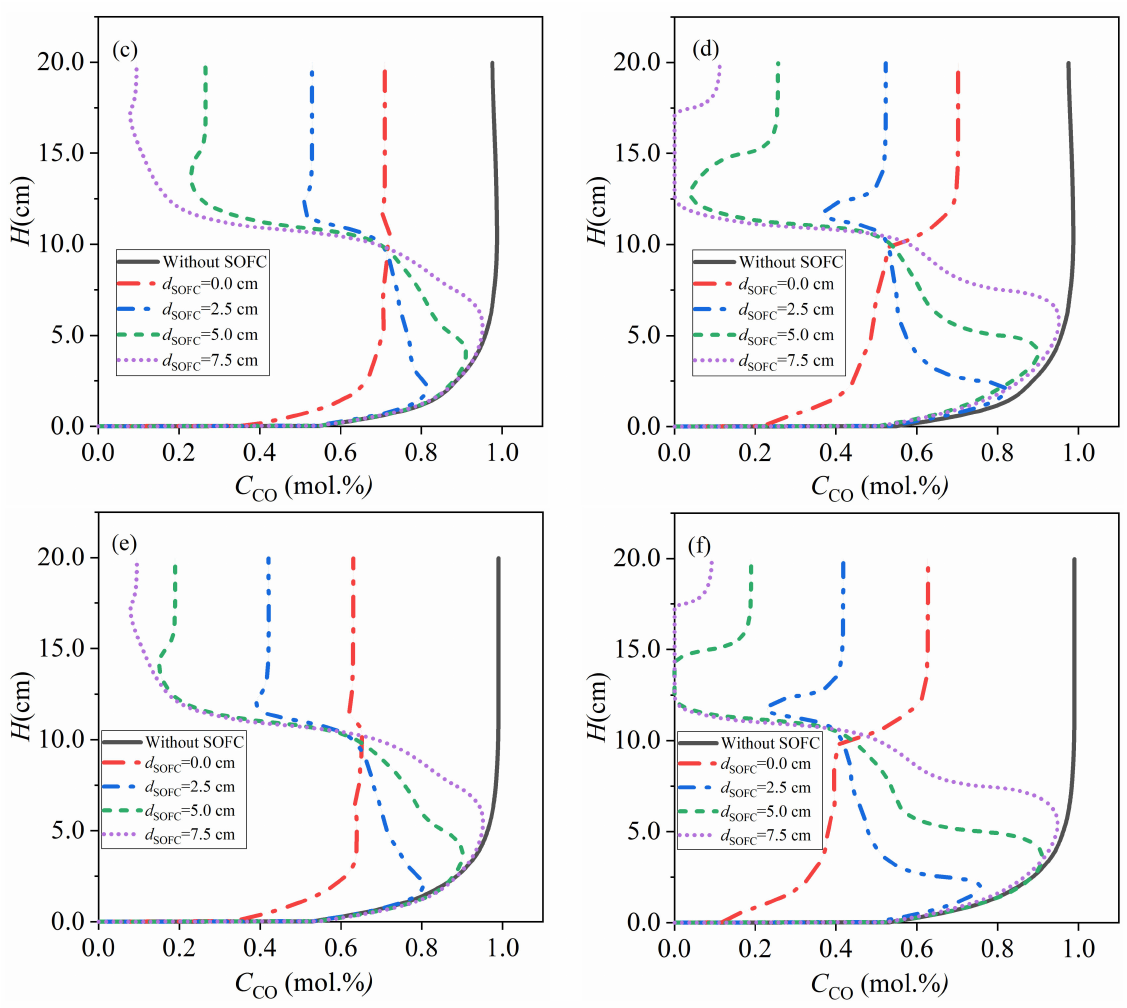
Figure 11. Averaged CO molar fractions ( a , c , e ) and CO molar fraction near side walls ( b , d , f ) along channel for delayed bub- bling bed gasifiers coupled with SOFC with A s = 7.2 × 10 − 5 mol/m 2 , v CO ( e , f ) 10,000 A/m 2